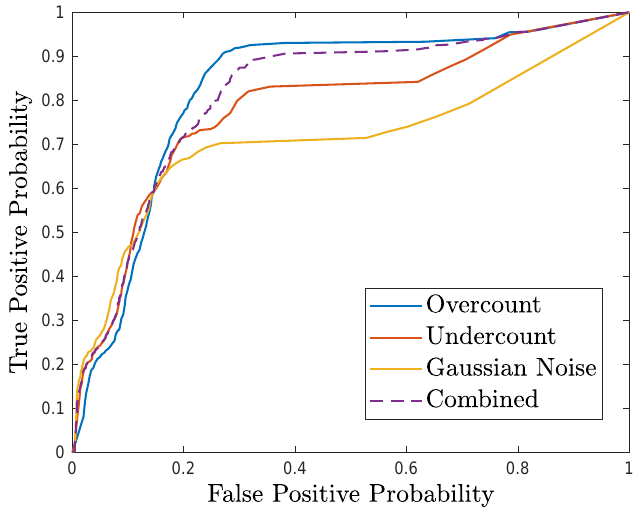
Figure 6. Trade-off between true positive and false positive errors for s EW